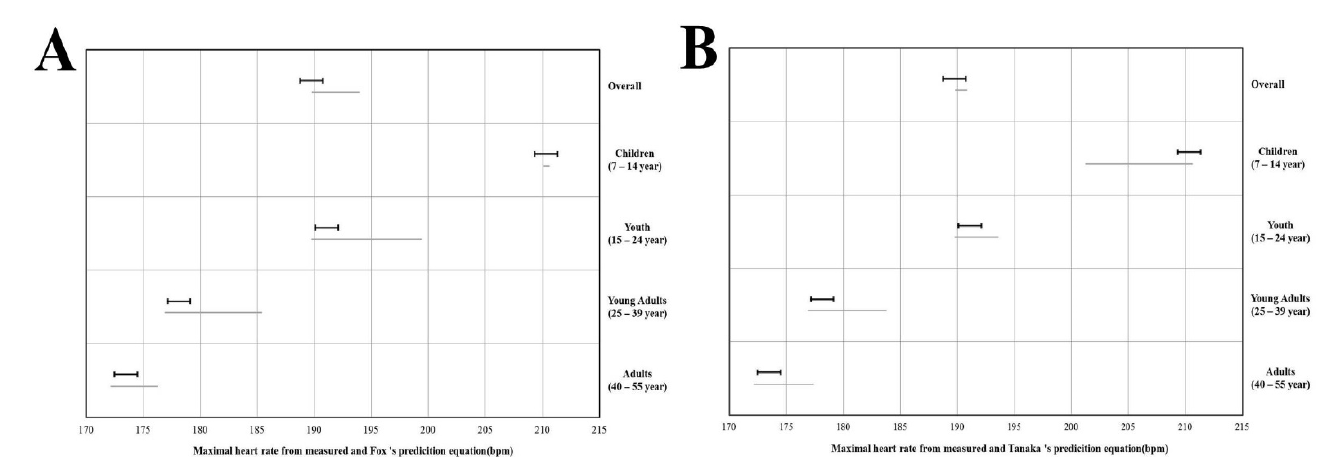
Figure 2. Dark lines mean equivalence zone (±10% of the mean). Grey lines are the 90% confidence interval for a mean of the estimated maximal heart rate prediction equation. ( A ) Equivalence testing in maximal heart rate measured by direct measurement and Fox ′ s equation; ( B ) equivalence testing in maximal heart rate measured by direct measurement and Tanaka ′ s equation.